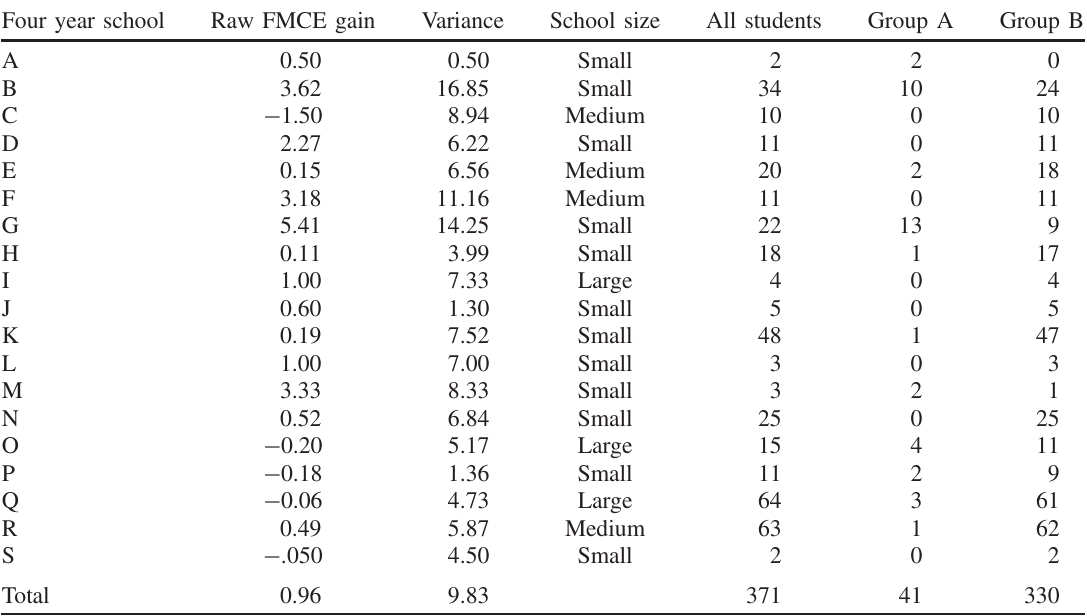
TABLE V. Comparison of schools distributed within